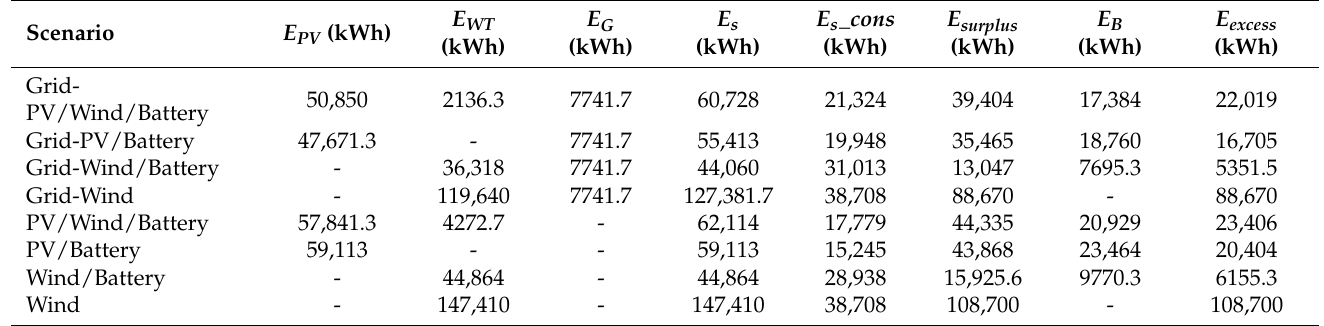
Table 5. Annual energy balance corresponding to the optimal characteristic of the studied systems.